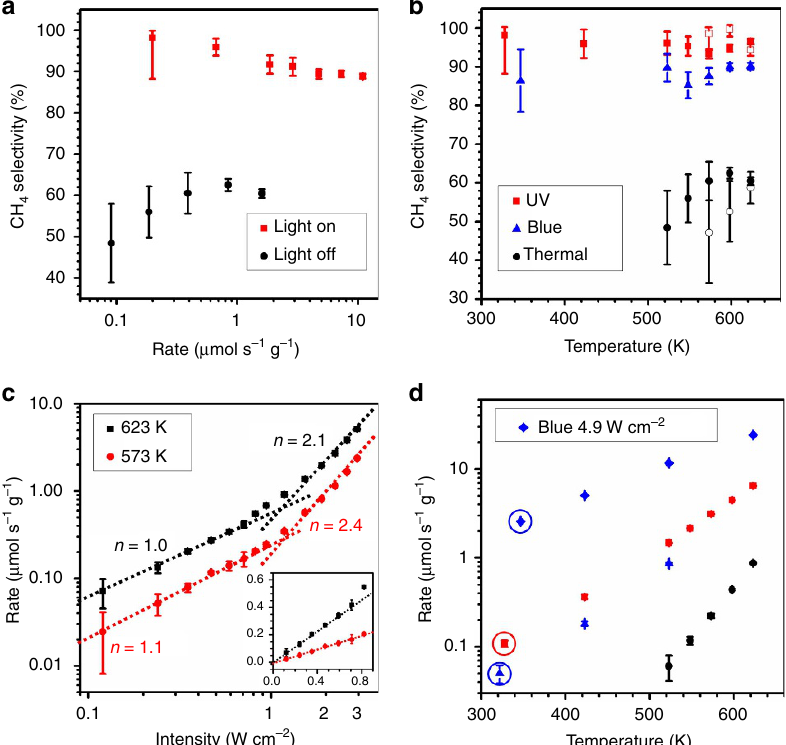
Figure 2 | Product selectivity and reaction rates on the rhodium photocatalyst. ( a ) Selectivity towards CH 4 as a function of overall reaction rates in dark (black circles) and under ultraviolet light at 3Wcm (cid:2) 2 (red squares). ( b ) Selectivity towards CH 4 of the thermo- (black circles) and photocatalytic reactions under ultraviolet (365nm, red squares) and blue (460nm, blue triangles) illumination as a function of temperature under H 2 -rich (CO 2 :H 2 ¼ 1:5.5, solid symbols) and H 2 -deficient (CO 2 :H 2 ¼ 1:3.1, open symbols) conditions. The photoreaction rates are calculated by subtracting the thermocatalytic reaction rates from overall reaction rates at the same temperature. The photoreactions under ultraviolet light show higher selectivity towards CH 4 than under blue light, which are both much higher than that of the thermocatalytic reaction. ( c ) Rates of CH 4 photo-production as a function of ultraviolet light intensity at 623 (black squares) and 573K (red circles). The intensity-dependent reaction rates show a linear to super-linear transition with increasing light intensity. The inset shows the intensity-dependent reaction rates in the linear region. ( d ) Overall, CH 4 production rates in dark (black circles) and under ultraviolet (red squares, 3Wcm (cid:2) 2 ) and blue (blue triangles, 2.4Wcm (cid:2) 2 ) LEDs with the same photon flux, and with twice the blue photon flux (blue diamonds, 4.9Wcm (cid:2) 2 ). Ultraviolet light is more efficient at enhancing the reaction rates than blue light with the same photon flux. Circled points show the unheated steady-state temperatures and reaction rates. Error bars represent the s.d. of measurements by the mass